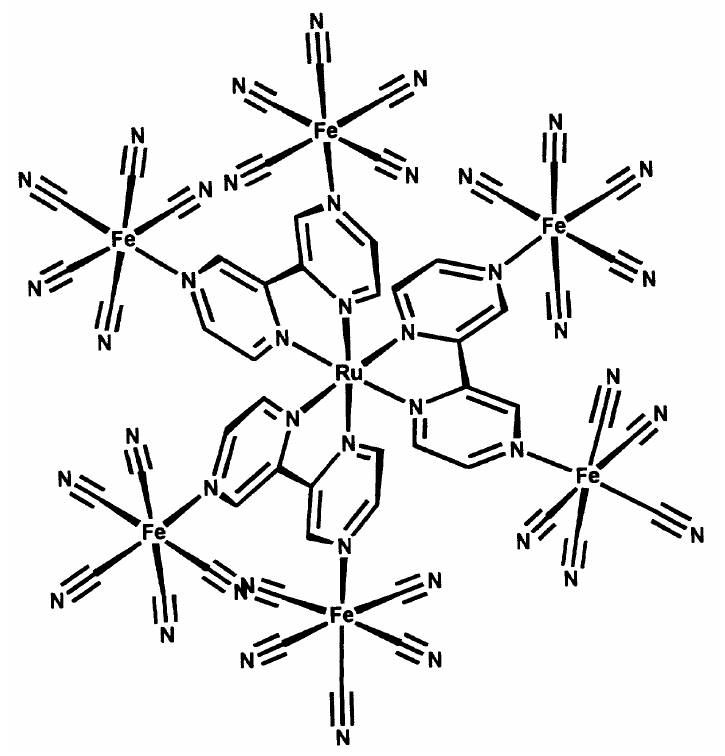
Fig. 3 – Structural representation of the [Ru(bpz) 3 {Fe(CN) 5 } 6 ] 16 −